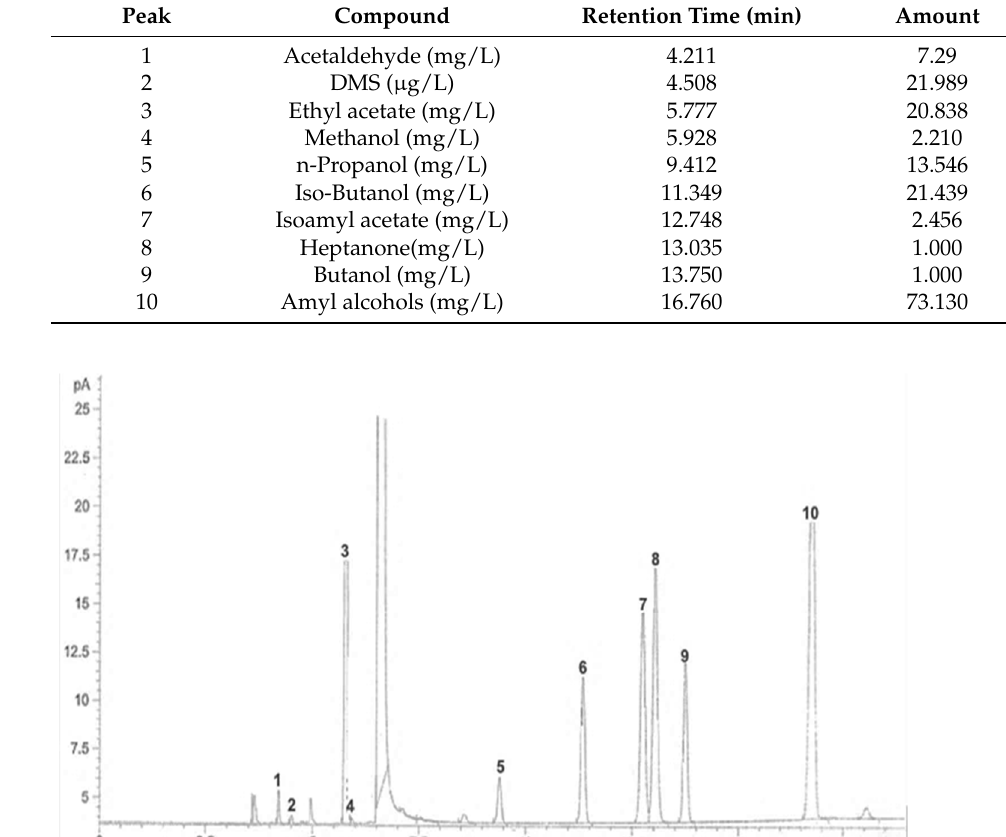
Figure 3. Chromatogram of a beer sample on a DBWAX column. Table 6. Aromatic compounds of a final product of beer under classical fermentation.